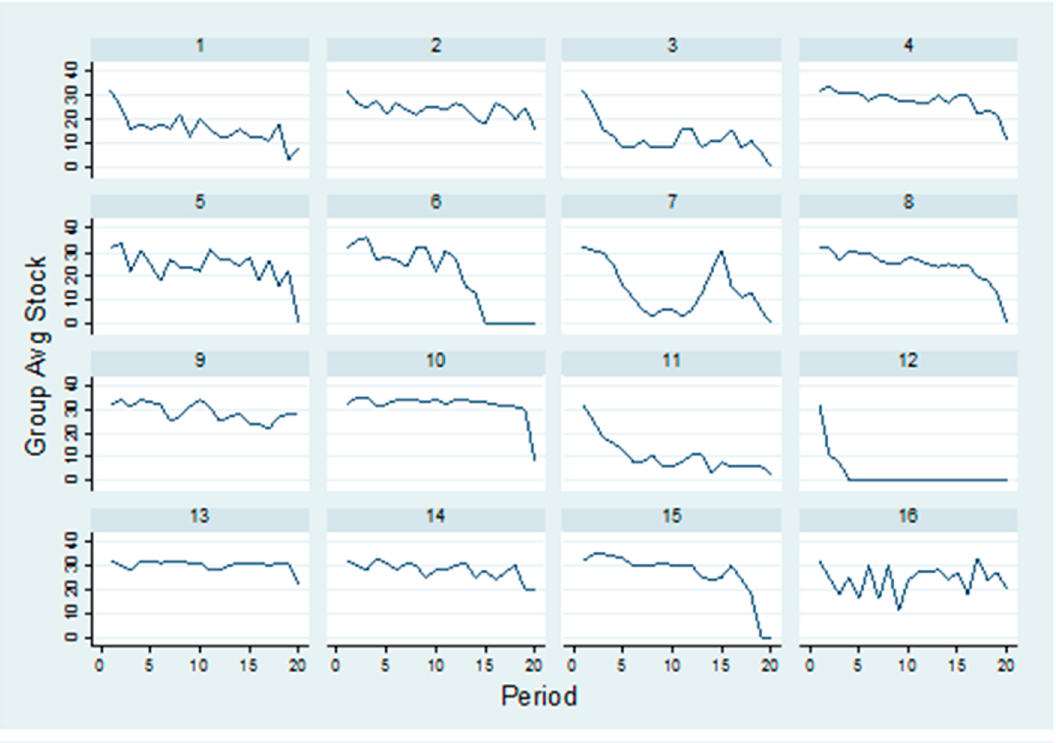
Figure A3. Stock at the end of each round (for all 16 groups). Games 2018 , 9 , x FOR PEER REVIEW